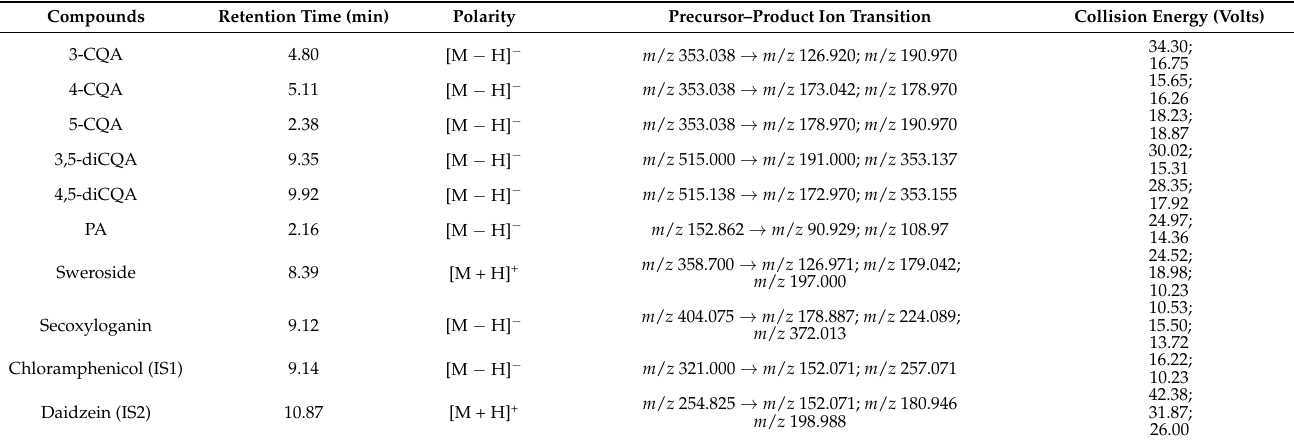
Figure 1. Chemical structures of the eight compounds and two internal standards (ISs). Table 1. Quantitative ions and MS parameters of nine analytes and ISs.